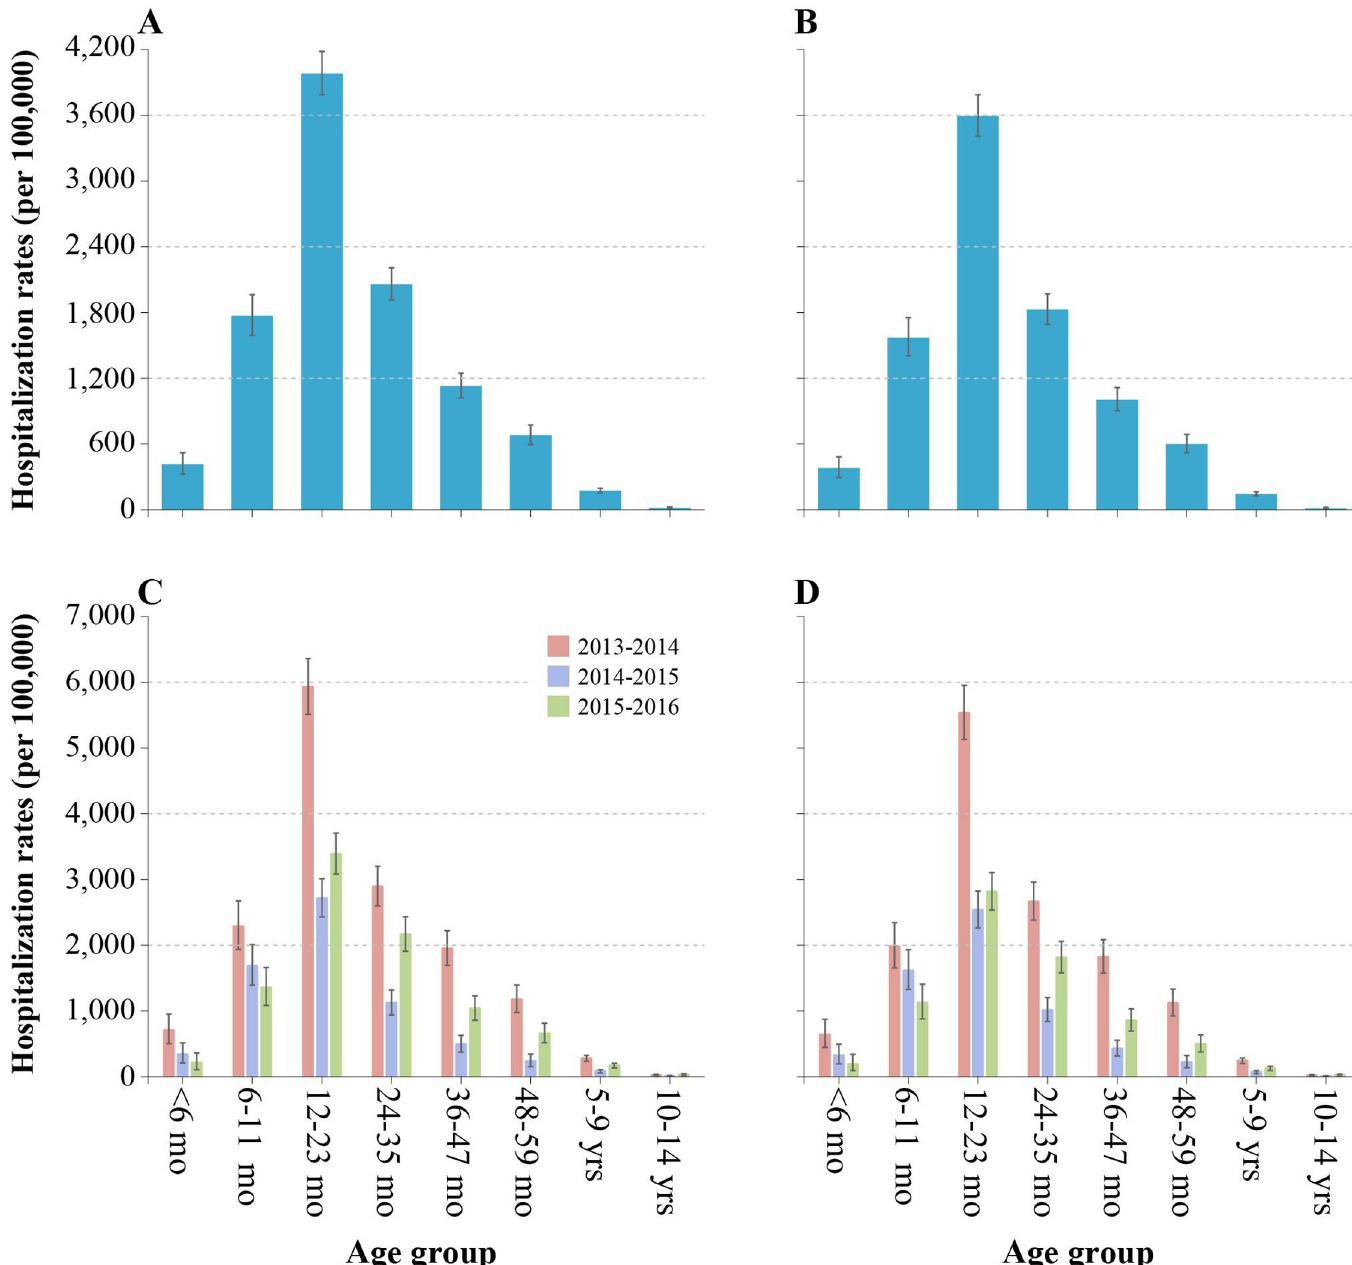
Fig 3. Age-specific hospitalization rates associated with HFMD in Anhua County, China, October 2013—September 2016. (A) Average age-specific hospitalization rates of probable HFMD. (B) Average age-specific hospitalization rates of lab-confirmed HFMD. (C) Annual age-specific hospitalization rates of probable HFMD. (D) Annual age-specific hospitalization rates of lab-confirmed